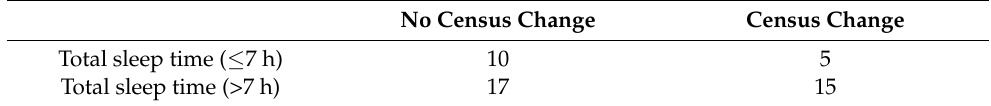
Table 3. Total sleep time and census